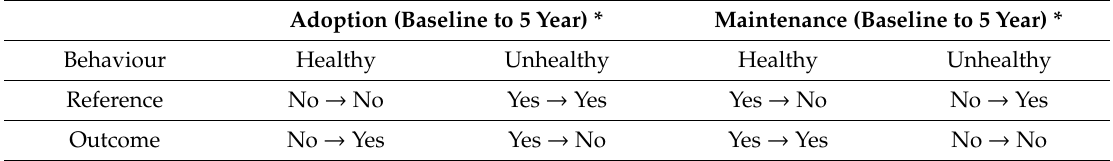
Table 1. Reference and outcome groups for lifestyle behaviour change from baseline to the 5-year